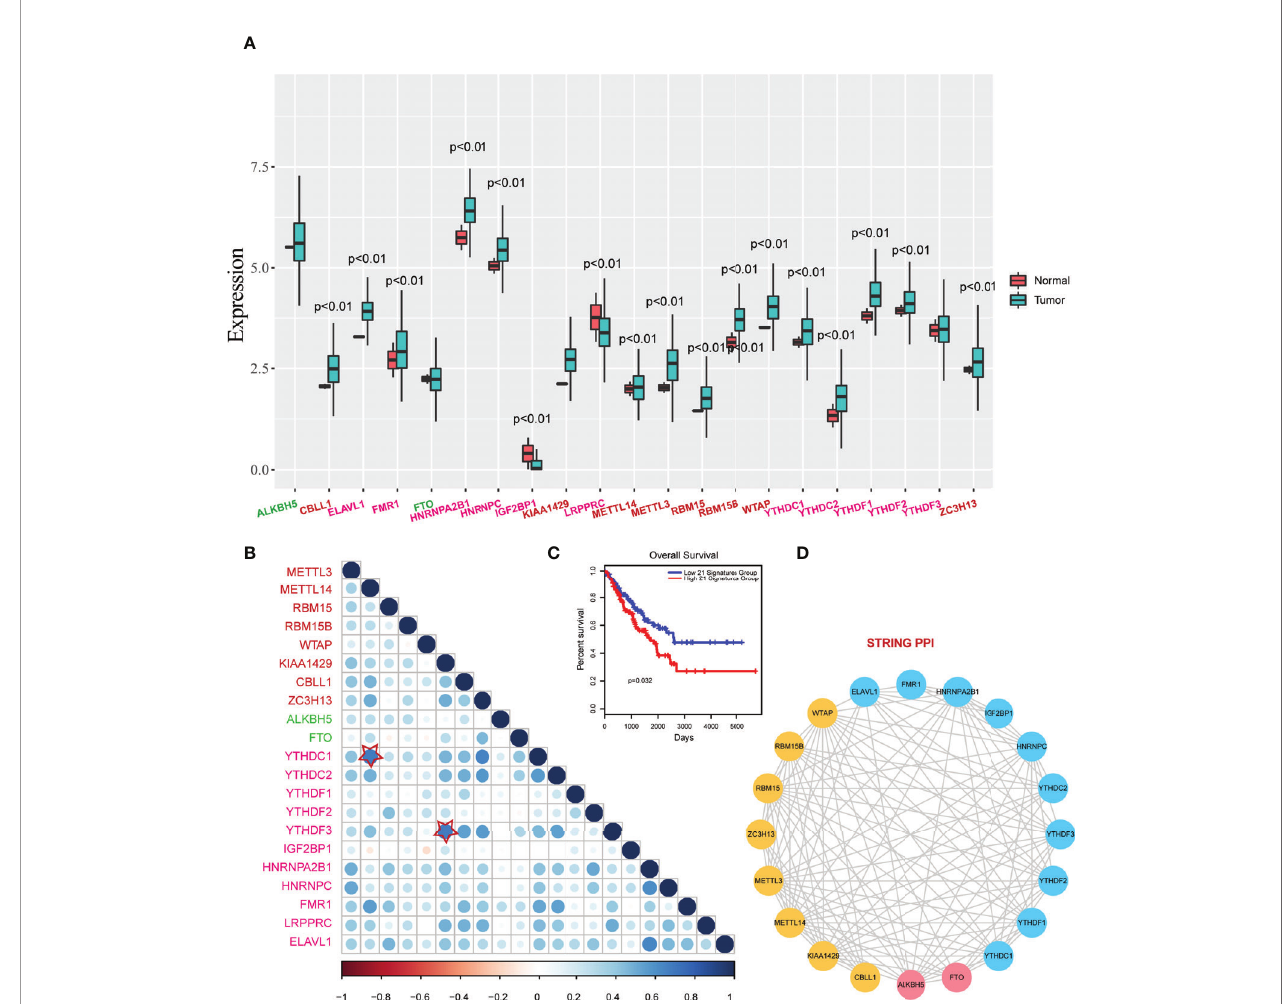
FIGURE 2 | Expression changes and correlations of m6A regulators in sarcoma. (A) The boxplots of expression changes of m6A regulators between controls and tumors. P <0.01 represents the expression levels were signi fi cantly changed in tumor groups vs. control groups. (B) Pearson correlations of m6A regulators in sarcoma. Star-labeled nodes represent the higher crosstalks: KIAA1429- YTHDF3 and METTL14-YTHDN1. (C) A Kaplan-Meier survival curve of m6A regulators (risk score model) in sarcoma (P=0.032). (D) PPI interactions of m6A regulators in String